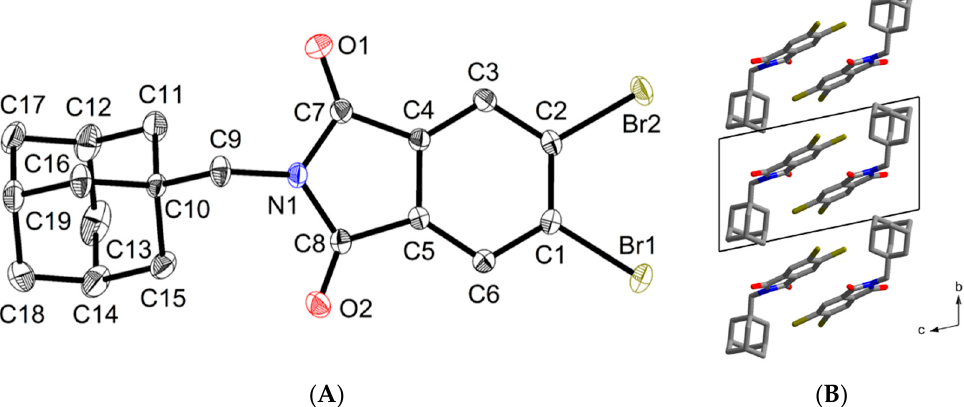
Figure 4. ( A ) ORTEP diagram of AdBr . Thermal ellipsoids are shown at the 50% probability level. Hydrogen atoms have been omitted for the purpose of clarity. Selected distances (Å) and angles ( ◦ ): Br1-C1, 1.8832(8); Br2-C2,